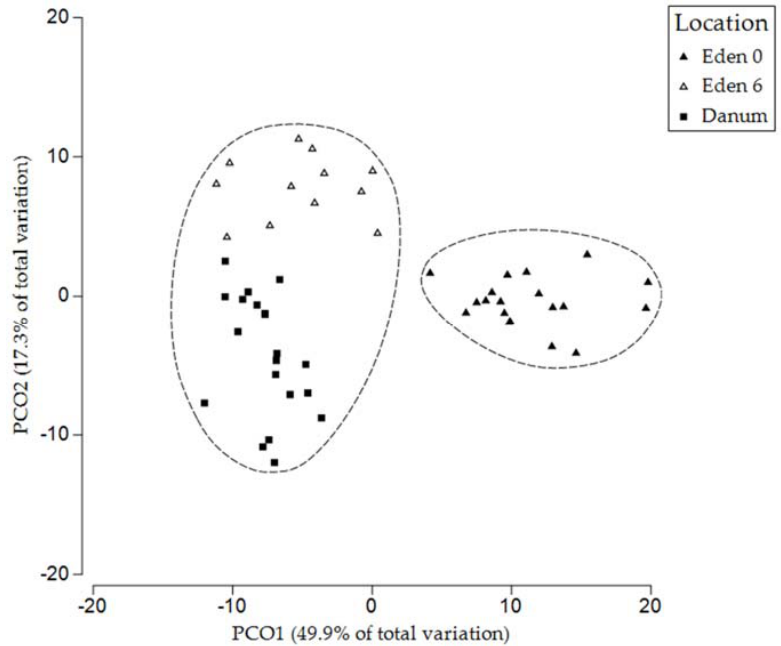
Figure 5. The PLFA profile of bird’s nest fern soils collected from the Eden Project prior to placement in the canopy, after 6 months in the canopy, and from natural fern soils collected in Danum Valley. Dashed lines enclose points within 80% similarity envelopes.